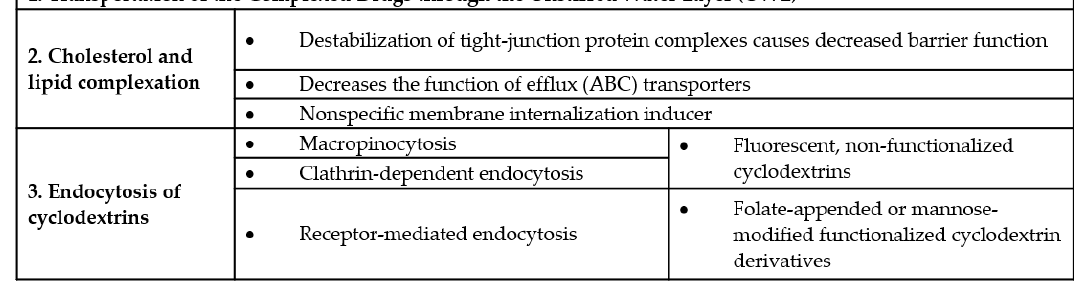
Figure 7. E ff ects of cyclodextrins on biological Figure 7. Effects of cyclodextrins on biological barriers.